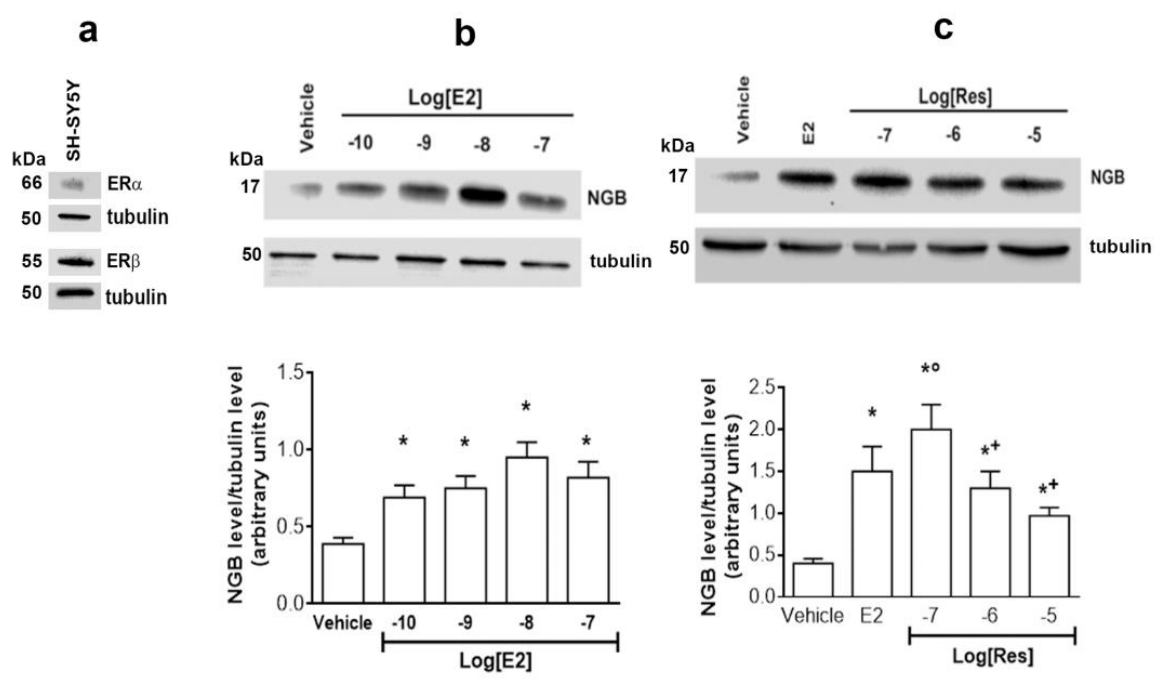
Figure 1. Modulation of NGB levels by E2 and Res. ( a ) Western blot analysis of the levels of the two receptor subtypes ER α and ER β in SH-SY5Y cells. ( b , c ) Western blot analysis of neuroglobin (NGB) levels in SH-SY5Y cells treated for 24 h with different concentrations of E2 (10 − 10 –10 − 7 M) (panel b) or Res (10 − 7 –10 − 5 M) (panel c) or with vehicle (DMSO 1:1000, v : v ). Tubulin protein was used to normalize blots. The upper panels show a Western blot type, and the lower panels report the densitometric analysis of at least three different experiments. Data are the mean ± SD. p < 0.01 was calculated with Student’s t -test with respect to vehicle (*) or with respect to E2 ( ◦ ) or with respect to Res 10 ~7 M ( + ).